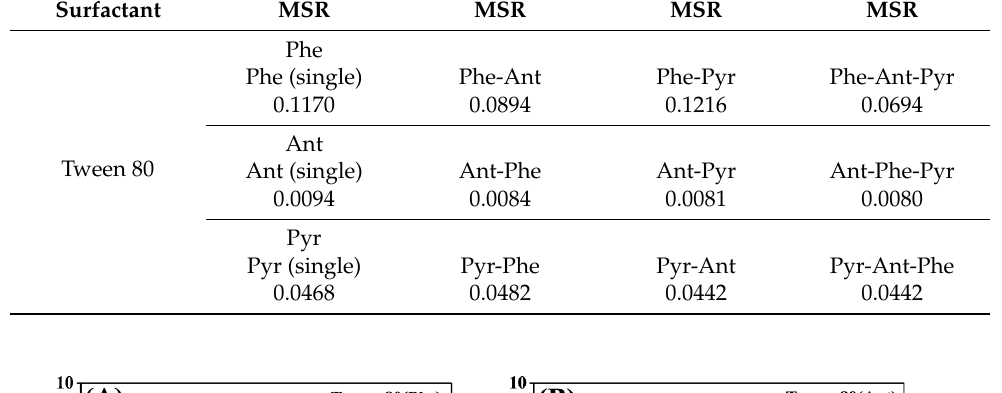
Table 1. MSR values of Phe, Ant and Pyr in single, binary or ternary solubilization systems in Tween 80 micellar solutions.